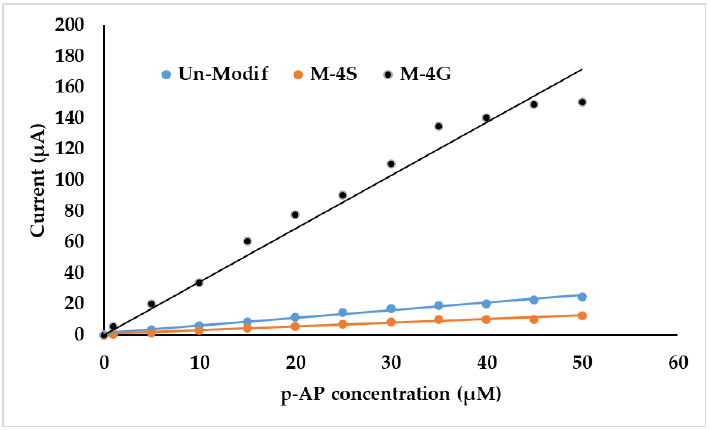
Figure 9. Linear regression of the relationship between p -AP concentration and anodic peak current. which is obtained from unmodified SPCE, SPCE-M-4G, and SPCE-M-4S. Table 3. Sensor performance parameters from SPCE; SPCE-M-4S, and SPCE-M-4G. Sensor